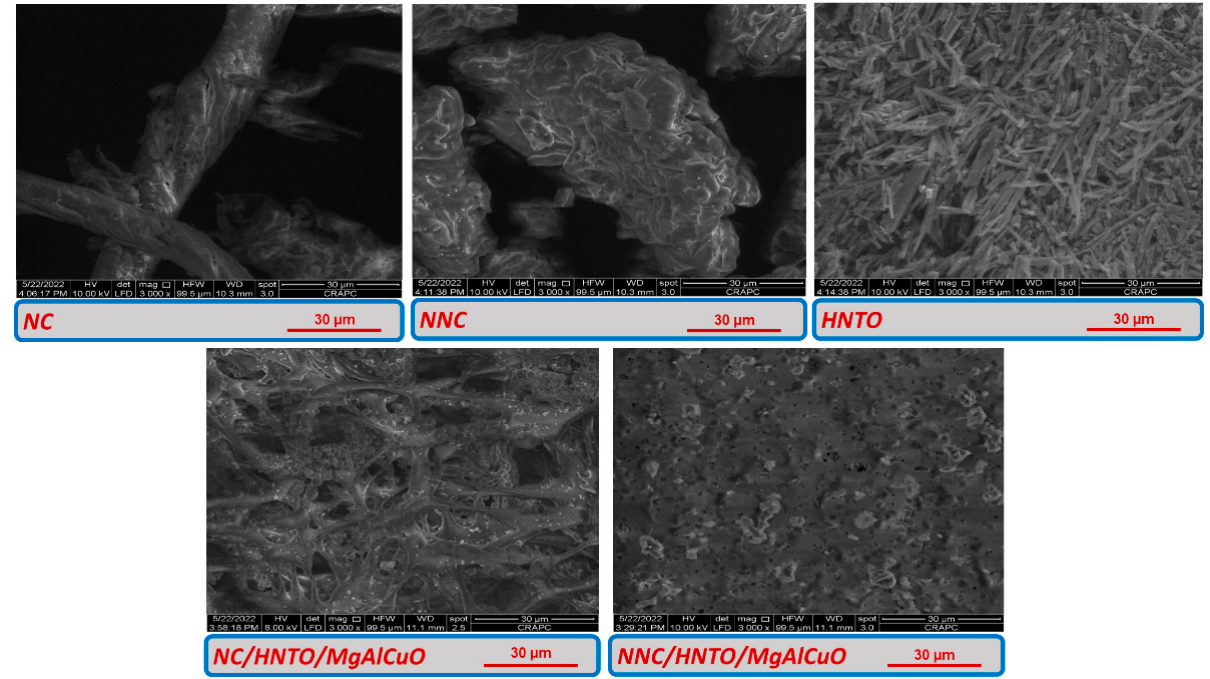
Figure 2. SEM images of the studied energetic composites and their raw